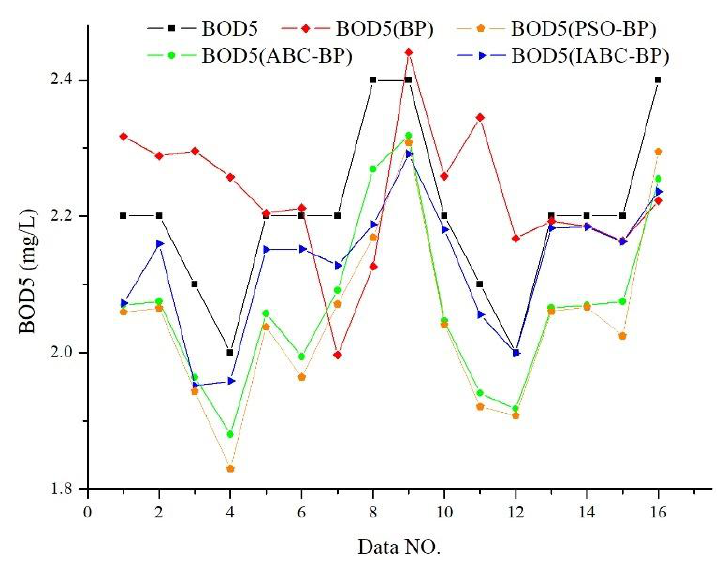
Figure 8. Comparison of BOD 5 among the four models.